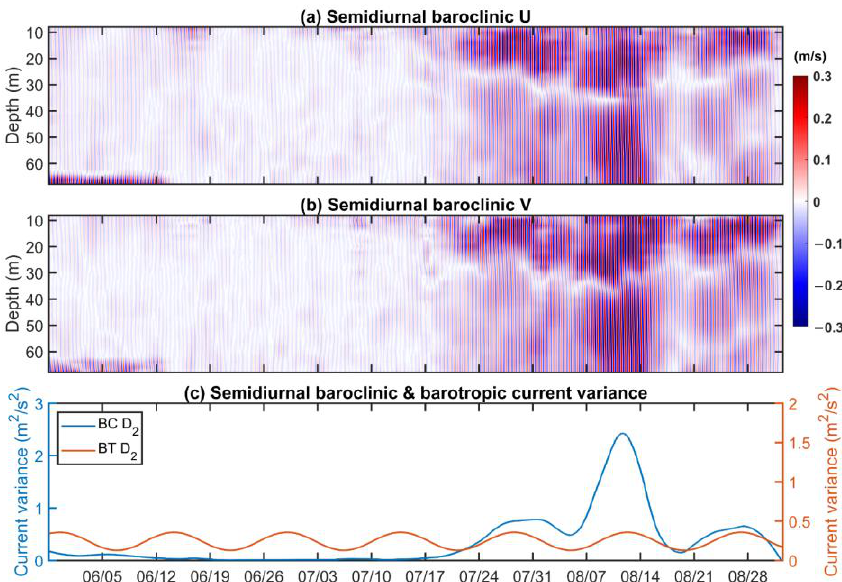
Figure 3. Time series of semidiurnal band baroclinic velocities (color, unit: m/s) derived from mooring observations from 29 May 2014 to 2 September 2014: ( a ) zonal component, ( b ) meridional component. ( c ) The vertically integrated current variance of baroclinic (blue) and local barotropic (M 2 + S 2 ) (red) tides predicted by TPXO 7.2.